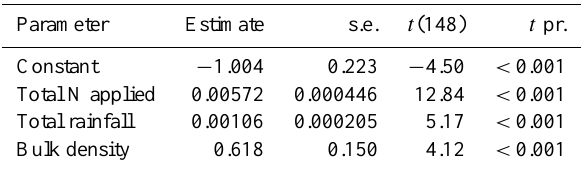
Table 5b. The parameter estimates, standard errors and the proba- bilities for the coefficients included in the multiple regressions for the grassland